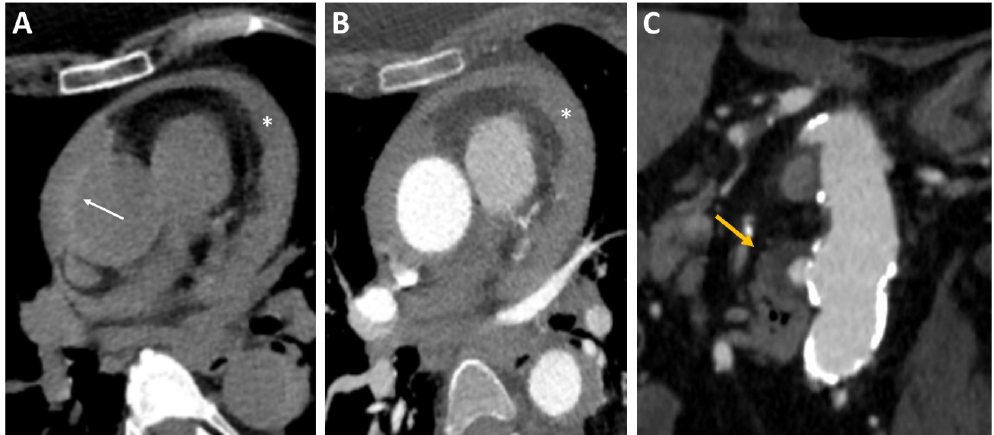
Figure 3. Intramural hematoma on CT using ( A ) non-contrast CT and ( B ) CT angiography: crescentic, high-attenuating regions of eccentrically thickened aortic wall on non-contrast CT (arrow). A diffuse pericardial effusion (*) was also visible in both scans. ( C ) Penetrating ulcer on CT: CT angiography image showing a penetrating ulcer of the descending aorta as a contrast ‐ filled, out ‐ pouching into the thickened aortic wall (arrow). CT, computed tomography.